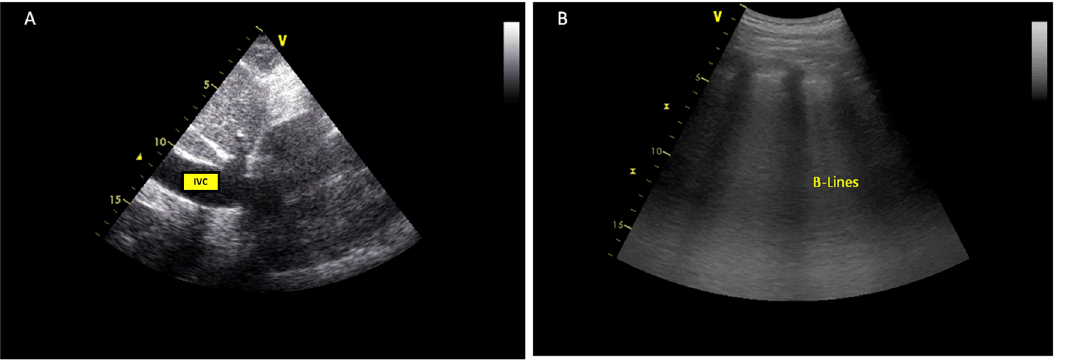
Figure 3. Echocardiographic markers of congestion. ( A ) increased IVC inferior vena cava (IVC) diameter; ( B ) lung ultrasound showing vertical B-lines as a measure of interstitial oedema.